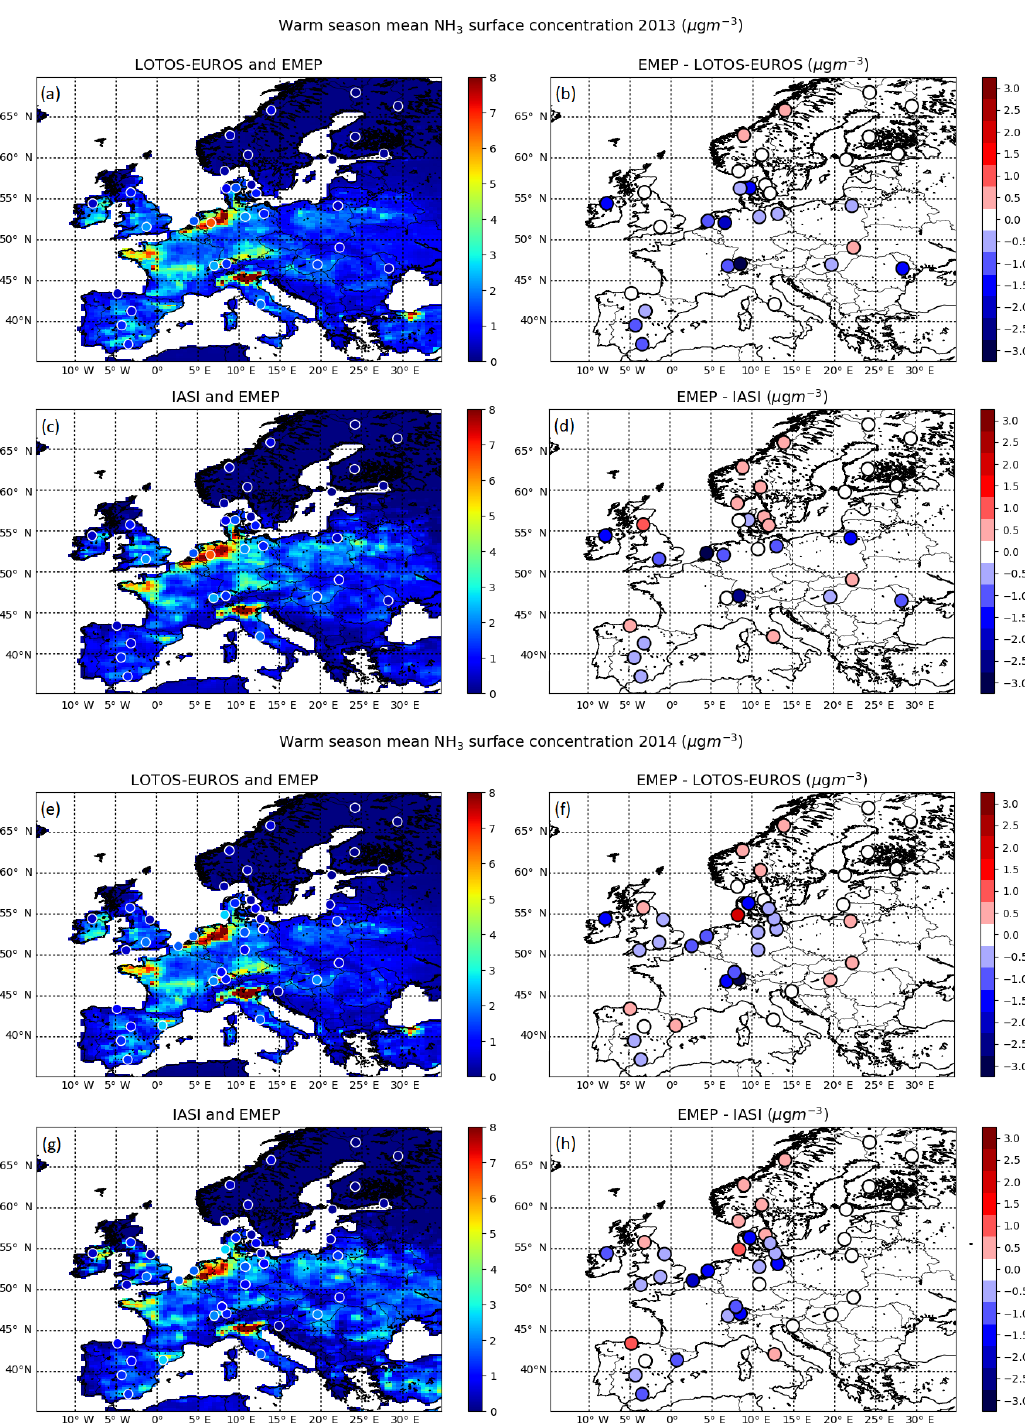
Figure 3. Comparison of the warm season (April–September) mean NH 3 surface concentrations (µgm − 3 ) from LOTOS-EUROS and derived from IASI and the warm season mean NH 3 surface concentrations measured by the EMEP stations in 2013 (a, b, c, d) and 2014 (e, f, g, h) . The absolute differences between the two are shown in the right